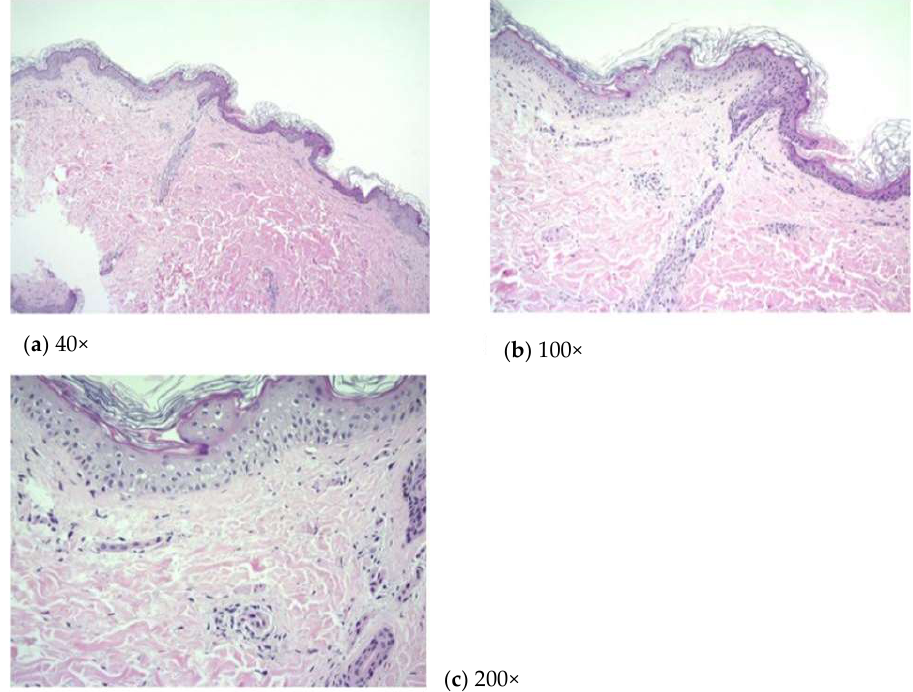
Figure 1. ( a ) 40 × ; ( b ) 100 × ; ( c ) 200 × . Mild lymphoplasmacytic infiltrations were observed in the Figure 1. ( a ) 40×; ( b ) 100×; ( c ) 200×. Mild lymphoplasmacytic infiltrations were observed in the peri- perivascular vascular area.